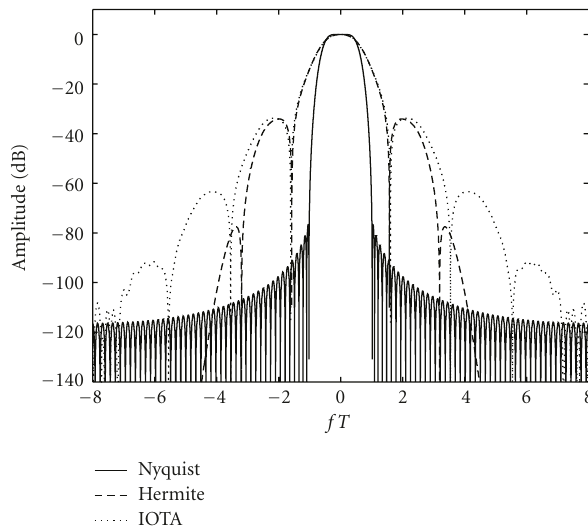
Figure 12: Magnitude of impulse response of three designs of prototype filter of length 6 T .